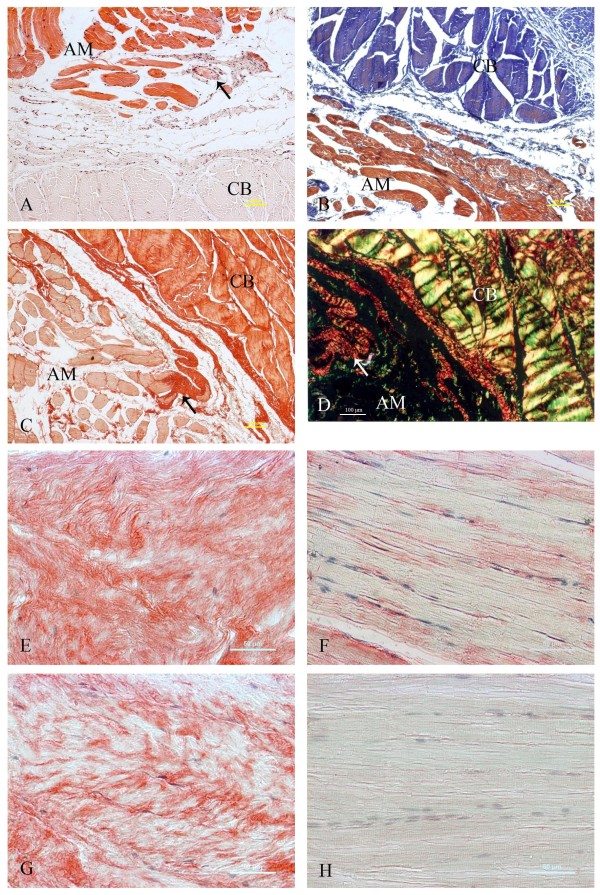
Histochemical analyses for muscle lesion and immunohistochemical analyses for collagen type I and type III. (A) Hematoxylin-eosin, (B) Masson trichrome and (C) picrosirius staining of the boundary between the contraction band (CB) and unaffected adjacent muscle (AM). Arrows indicate muscles that are undergoing fibrosis. (D) picrosirius staining of the boundary viewed under polarized light microscopy (collagen type I is yellow and type III is green). (E, F, G, H) Immunohistochemical staining of contraction band (E, G) or unaffected adjacent muscle (F, H) was carried out with antibodies against collagen type I (E, F) or collagen type III (G, H). Proteins specifically recognized by the antibodies are stained red, whereas nuclei are counter-stained blue. Scale bars: 100 μm (A, B, C, D), 50 μm (E, F, G, H).